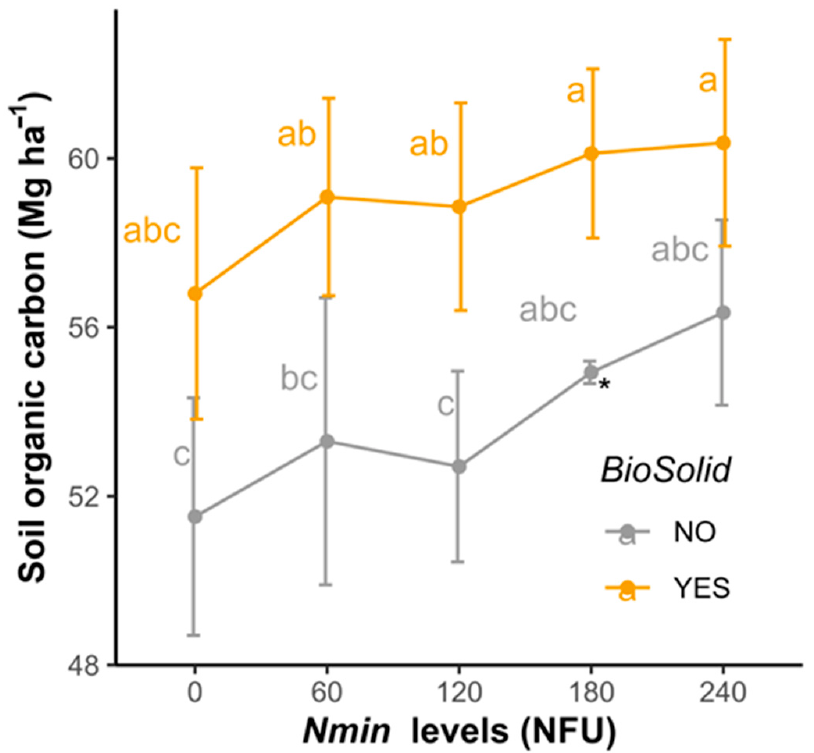
Figure 2. Soil organic carbon (Mg ha − 1 ) as a function of the Nmin and BioSolid levels. Treatments with the same letter are not significantly different ( α = 0.5). Error bars show 1 standard deviation of 4 replicated data. Symbol “ * ” denotes a group with one missing